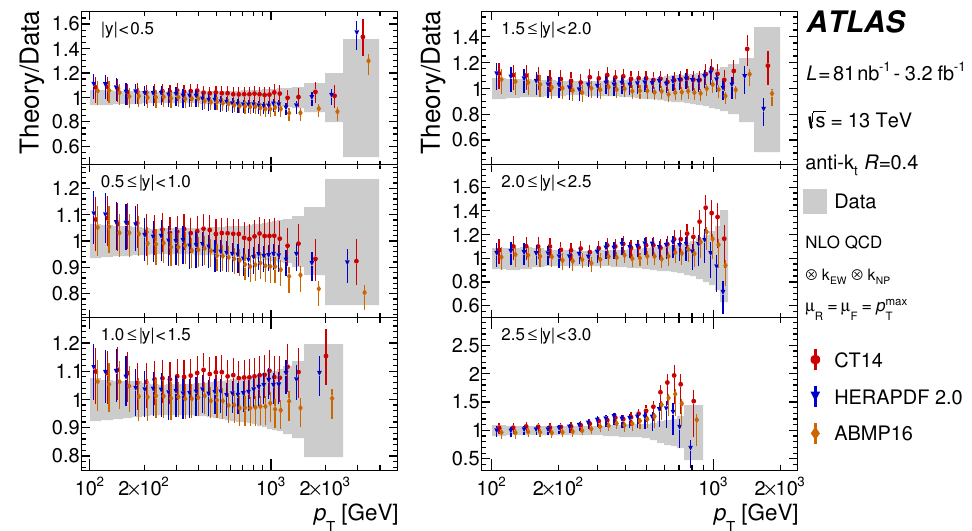
Figure 8 . Comparison of the measured inclusive jet cross-sections and the NLO pQCD predictions shown as the ratios of predictions to the measured cross-sections. The ratios are shown as a function of the jet p T in six j y j bins for anti- k t jets with R = 0 : 4. The predictions are calculated using NLOJET++ with three di(cid:11)erent PDF sets (CT14, HERAPDF 2.0, ABMP16) and non- perturbative and electroweak corrections are applied. The uncertainties of the predictions, shown by the coloured lines, include all the uncertainties discussed in section 9. The grey bands show the total data uncertainty including both the systematic (JES, JER, unfolding, jet cleaning, luminosity) and statistical uncertainties.